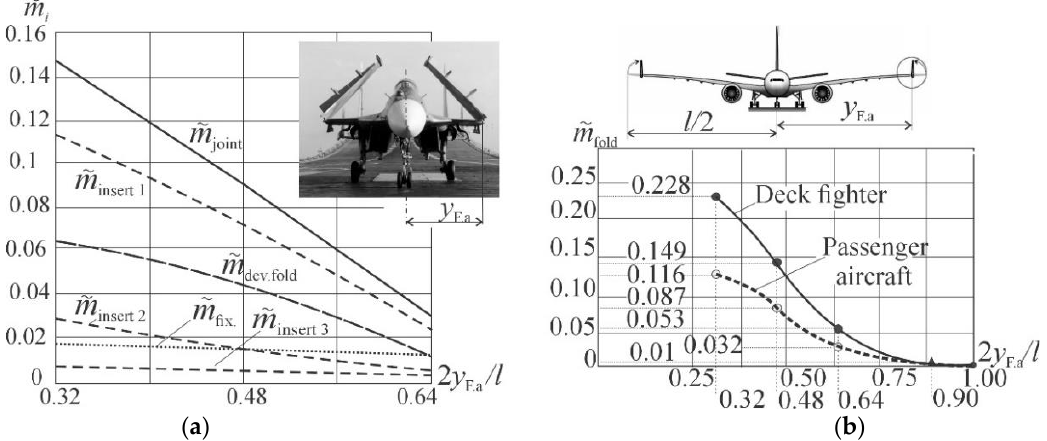
Figure 6. Mass fractions of elements of the device for folding along the wingspan of the torsion-box load-carrying layout: ( a ) for the deck-based fighter [43]; ( b ) a mass fraction of the whole folding device for the fighter and passenger aircraft wing.